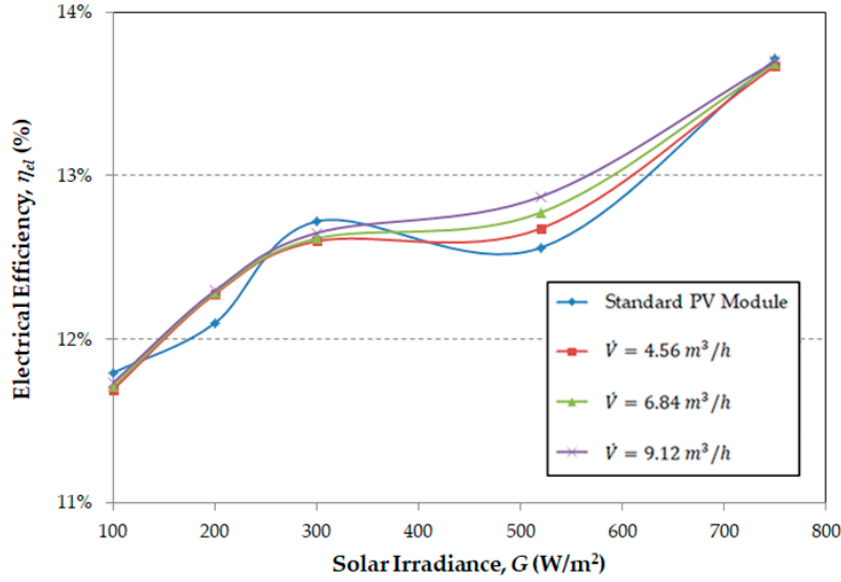
Figure 5. Influence of solar irradiance ( G ) on the photoelectric conversion efficiency ( η el ) of tested PV modules (standard and modified PV module for different ventilation intensities).